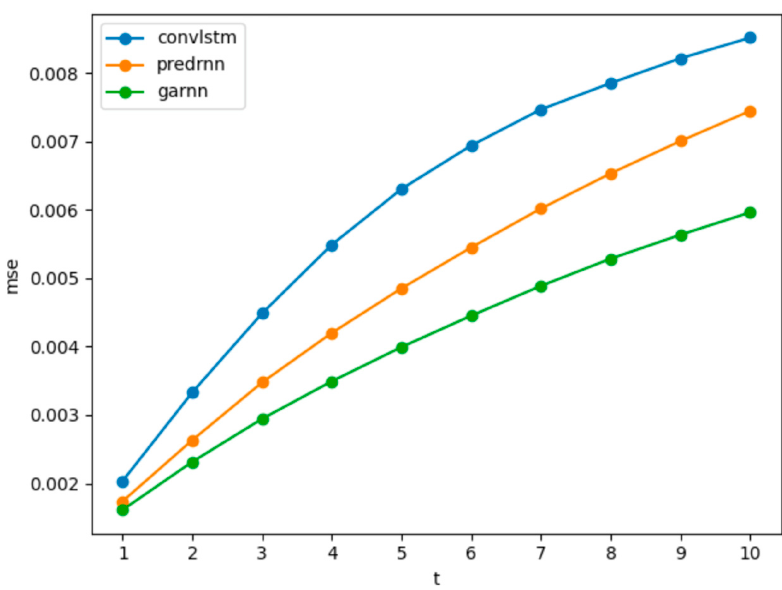
Figure 10. Frame-wise MSE of GARNN, ConvLSTM, and PredRNN. Table 1. Quantitative results comparison of GARNN, ConvLSTM, and PredRNN.